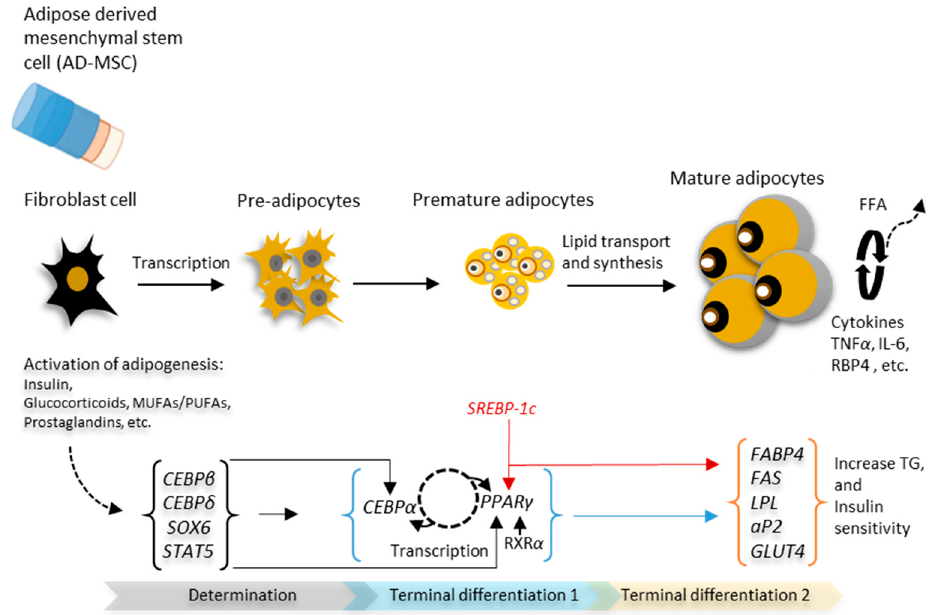
Figure 1. Schematic representation of adipocyte differentiation during adipogenesis. Adipocyte protein 2 = aP2 ; CCAAT/enhancer-binding protein = CEBP β and CEBP δ ; fatty-acid-binding protein = FABP4 ; glucose transporter type-4 = GLUT4 ; lipoprotein lipase = LPL ; peroxisome proliferator- activated receptor gamma = PPAR γ ; retinoic X-receptor = RXR α ; sterol regulatory element-binding protein-1c = SREBP-1c ; tumor necrosis factor-alpha = TNF α .